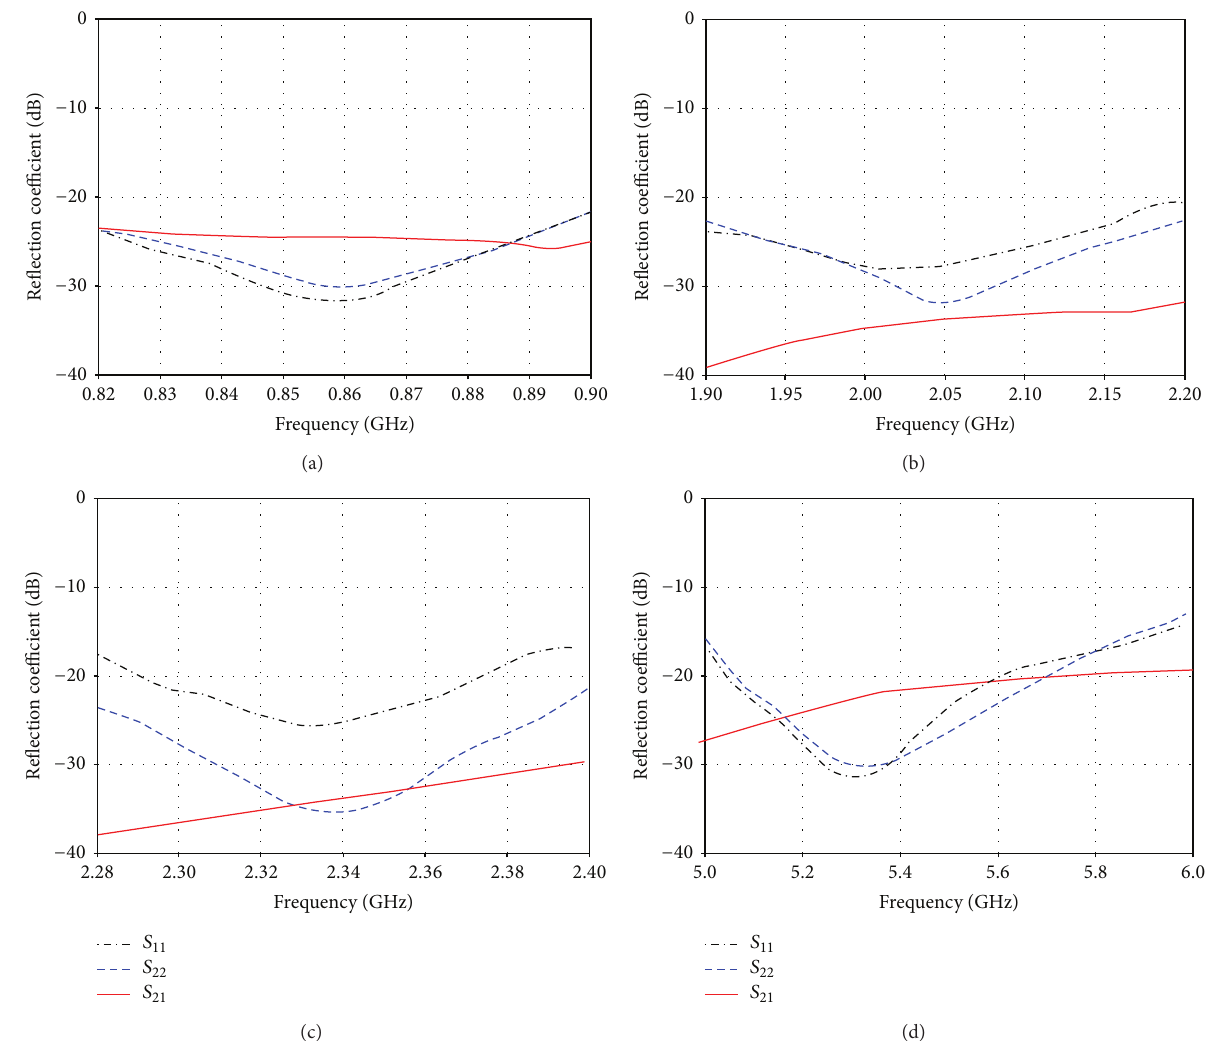
Figure 3: Simulated reflection coefficient and isolation characteristic of the radiators: (a) Band 1, (b) Band 2, (c) Band 3, and (d) Band 4.